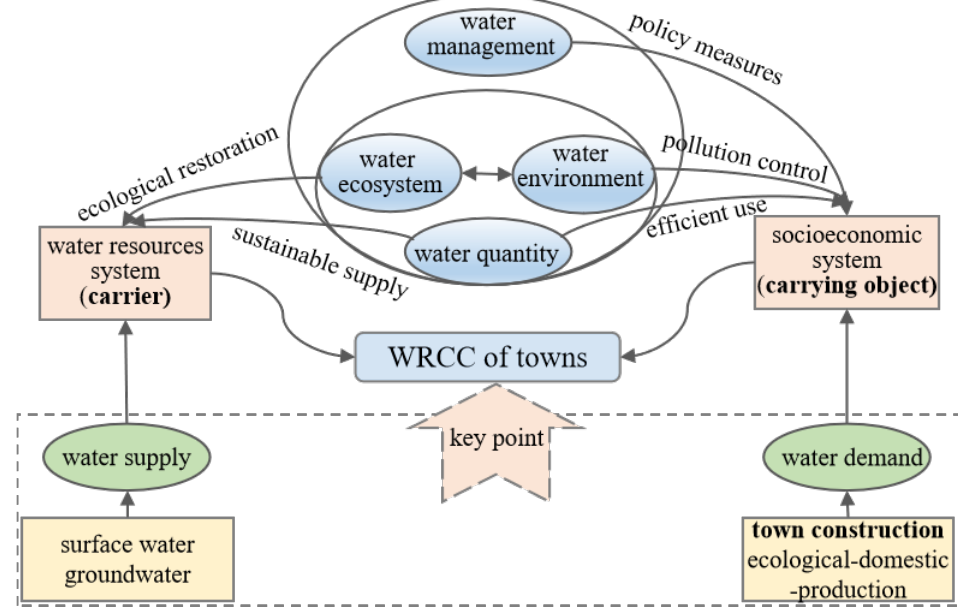
Figure 2. Flow chart of the analysis of the WRCC in the studied townships.